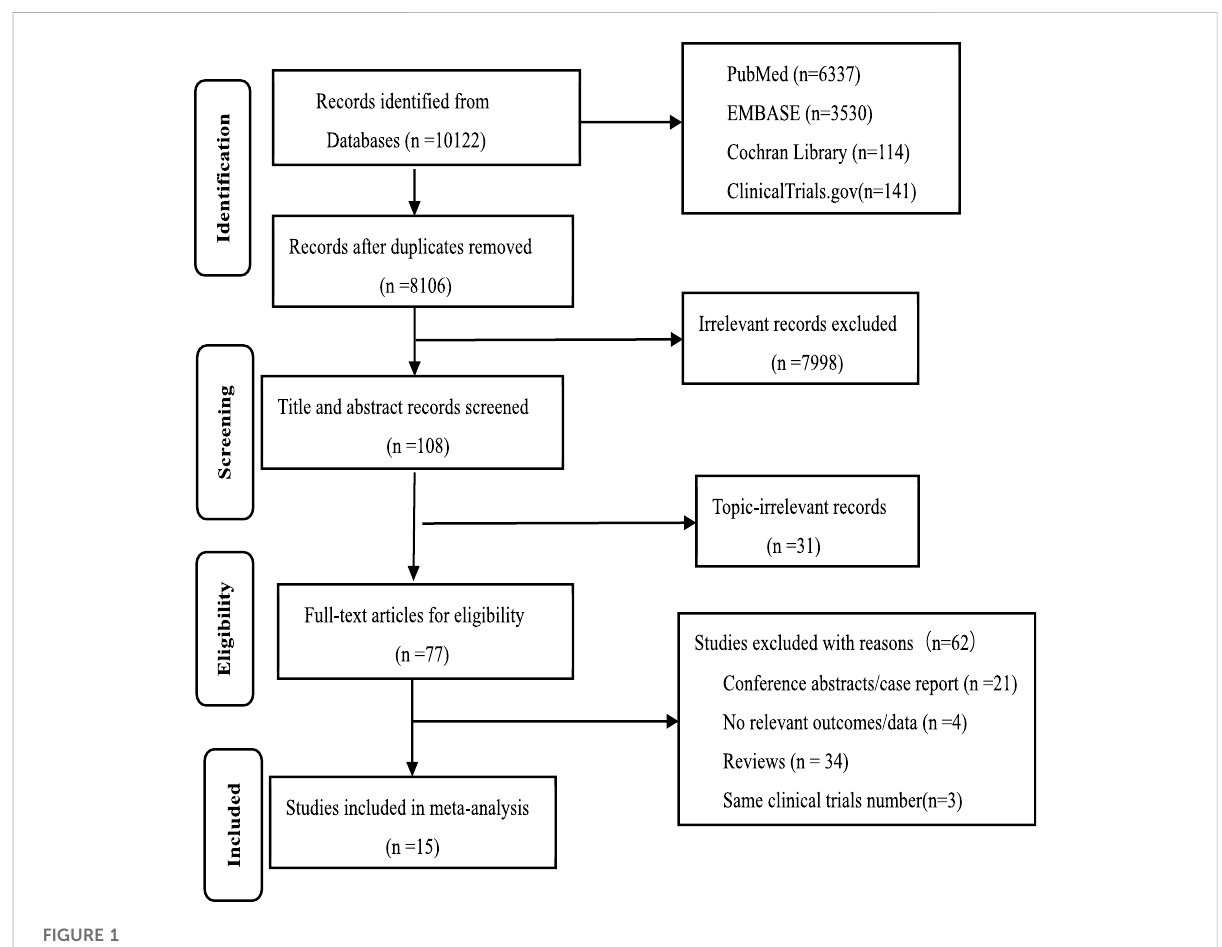
FIGURE 1 Flow chart of the study selection